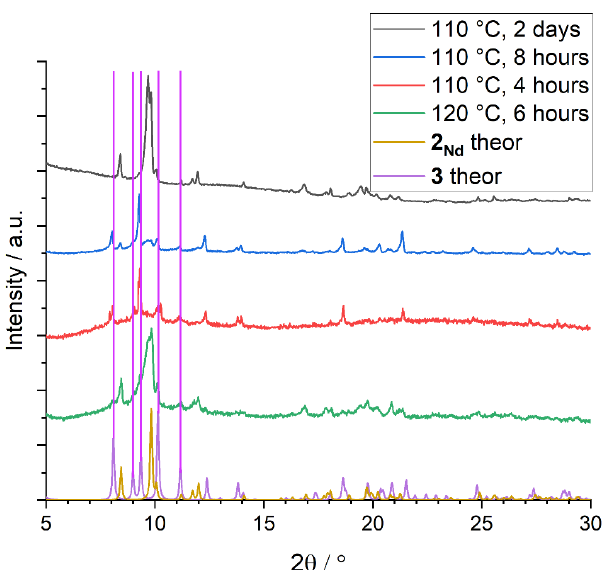
Figure 2. PXRD patterns for 2 Nd /3 temperature- and time-screening syntheses. Magenta lines show positions for lowest-angle reflections from the theoretical 3 structure.